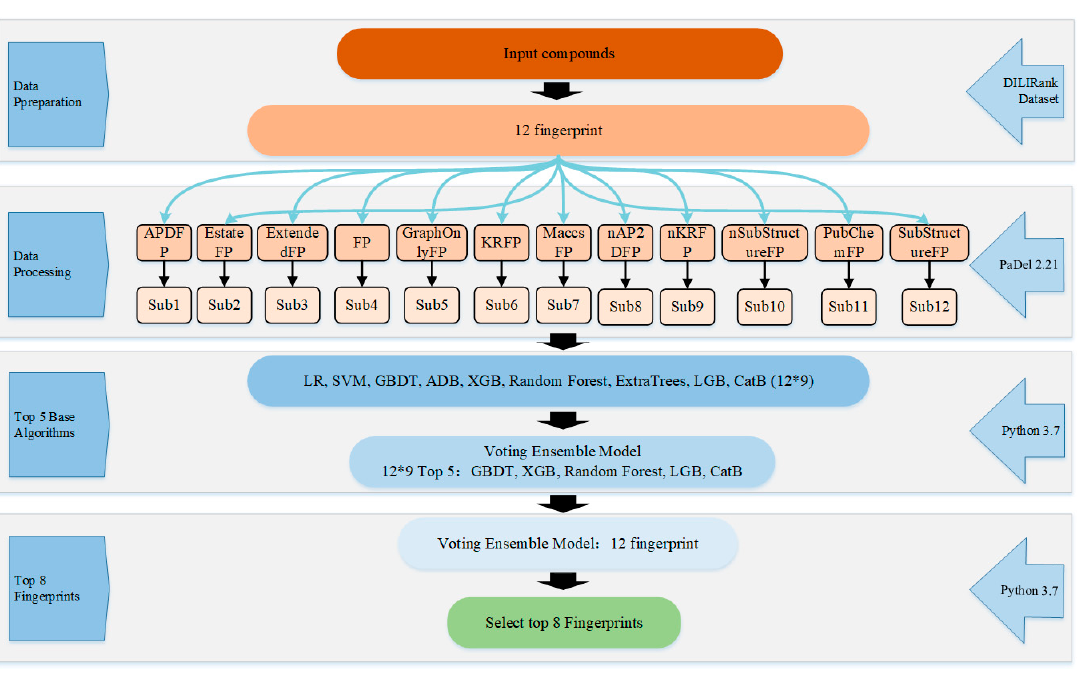
Figure 4. Flowchart of the ensemble classifier system with top 5 classifiers and top 8 fingerprint filters.